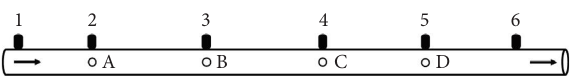
Figure 2: Diagram of the sensor arrangement structure. Table 1: Distance of each sensor from sensor No.